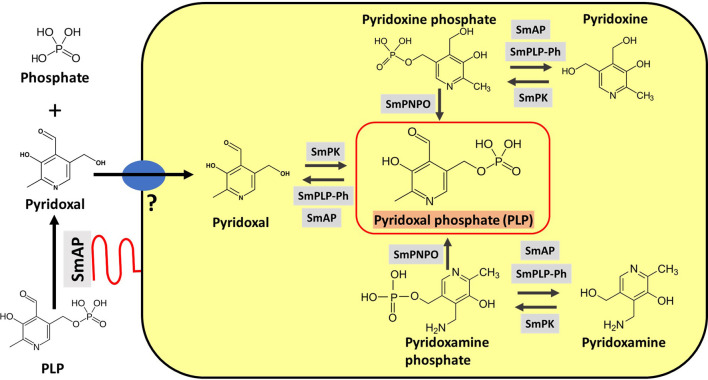
Vitamin B6 metabolism in schistosomes. SmAP (depicted at lower left, red) can cleave PLP to generate free pyridoxal which may be imported by schistosomes via an unidentified transporter protein (blue oval, left). Depicted in the yellow rectangle are hypothetical biochemical pathways in S. mansoni leading to the generation of PLP (bounded by the red box, center). Imported pyridoxal (left) may be phosphorylated by S. mansoni pyridoxal kinase (SmPK) to directly generate PLP; the vitamers pyridoxine (top) and pyridoxamine (bottom) may first be phosphorylated by SmPK to generate pyridoxine phosphate and pyridoxamine phosphate, respectively and these products may then be acted upon by S. mansoni pyridox(am)ine-5’-phosphate oxidase (SmPNPO) to generate PLP. Dephosphorylation of several vitamers may be driven by S. mansoni pyridoxal phosphate phosphatase (SmPLP-Ph) and/or SmAP.